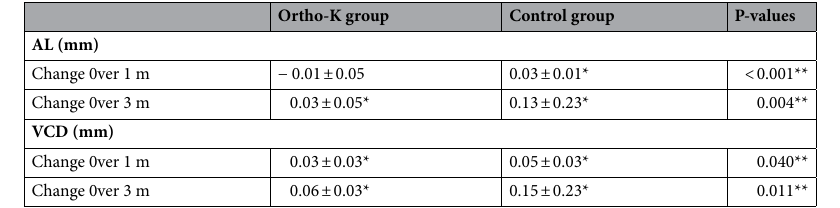
Table 2. Changes (mean ± SD) from baseline in ocular biometric parameters during 3 months of follow-up in two groups. AL: axial length, VCD: vitreous chamber depth, m: month. ** One-way ANOVA analyses, and p < 0.05 at two tails was considered to be statistically significant. *P < 0.05 by repeated-measure ANOVA. (comparison within groups).